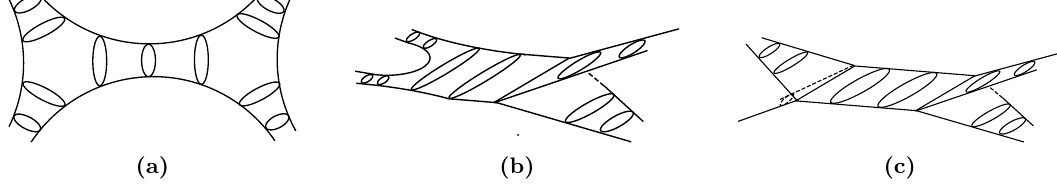
Figure 8. The two di(cid:11)erent kinds of vertices between three ladders, as was shown in (cid:12)gure 1, lead to three kinds of contributions to the eight-point